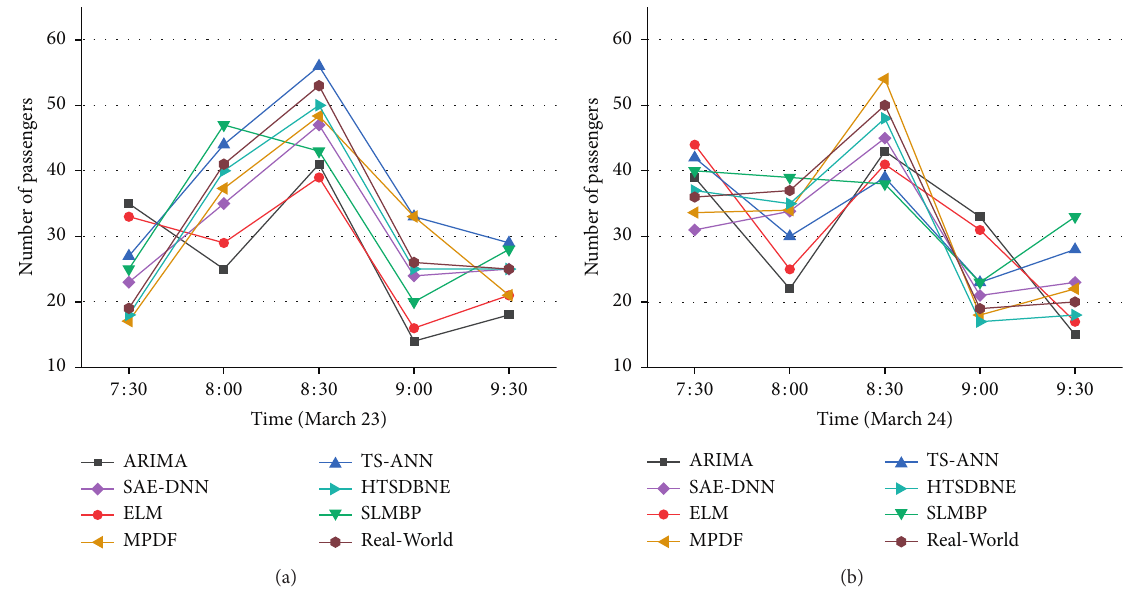
Figure 17: Comparison between HTSDBNE and other models in the morning peak hours of nonworking days (station 7 of line